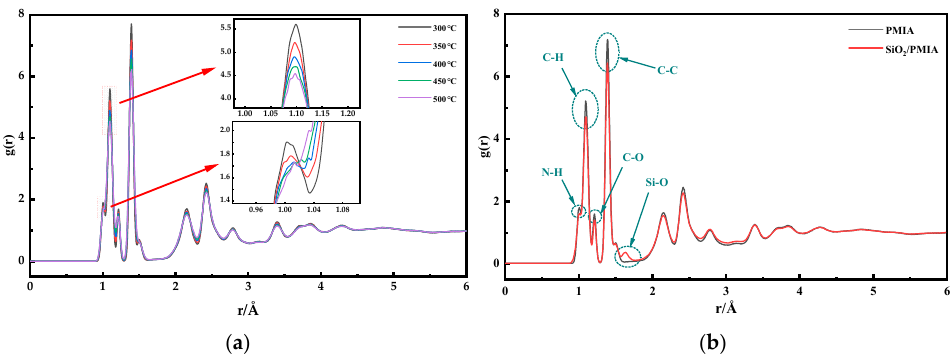
Figure 8. RDF of total atoms of the system ( a ) PMIA system in different temperature; ( b ) PMIA and SiO 2 /PMIA systems.